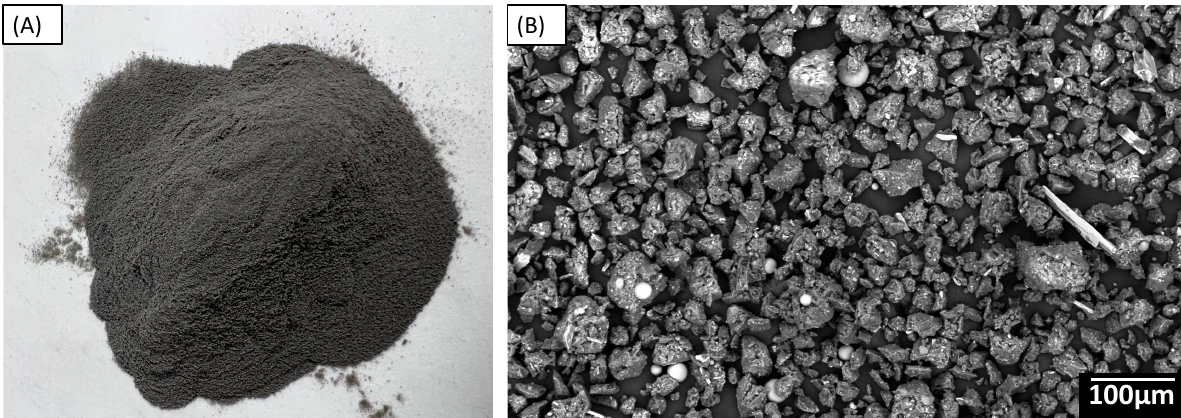
Figure 1. ( A ) Commercially available epoxy-based thermosetting PPP powder ( B ) SEM of epoxy- based thermoset powder blended with di ff erent resins, hardness, additives, pigments, and fi llers.